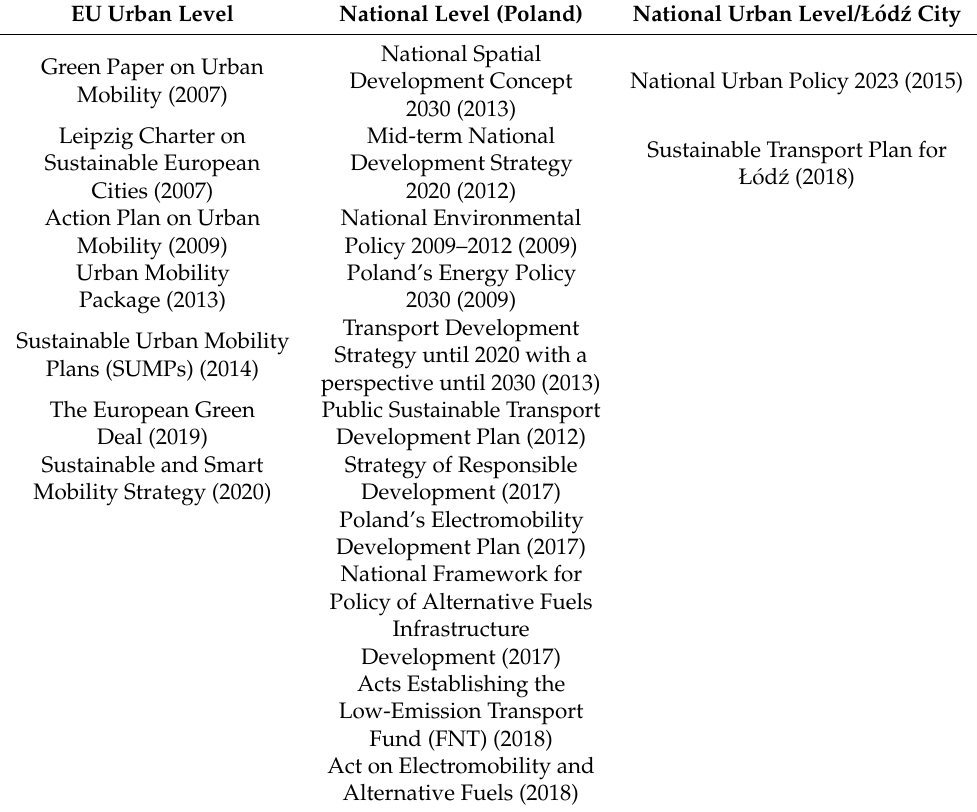
Table 1. Documents related to sustainable urban mobility planning in the EU, Poland, and Ł ó